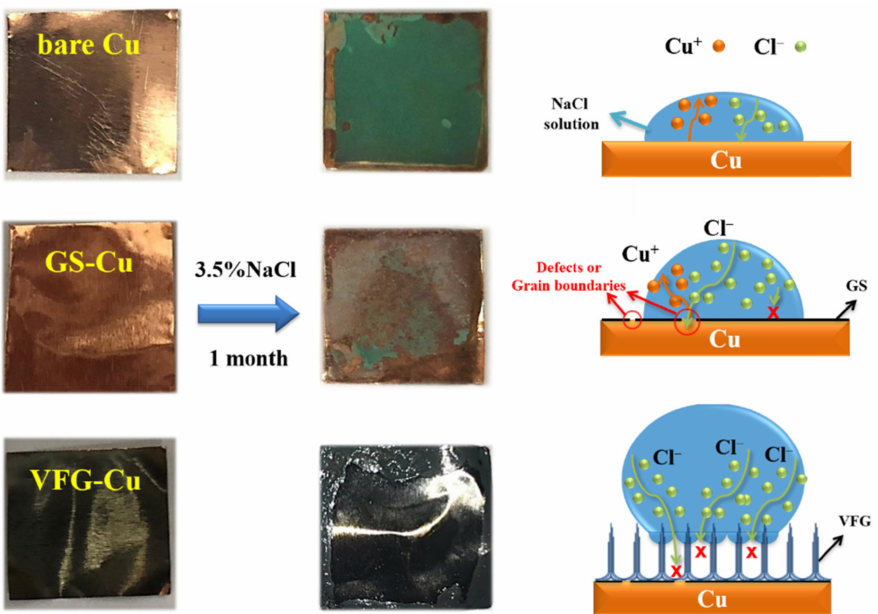
Figure 6. Morphologies of Cu, GS-Cu, and VFG-Cu before and after exposure to aqueous 3.5% NaCl for 1 month, and schematic of the anticorrosion